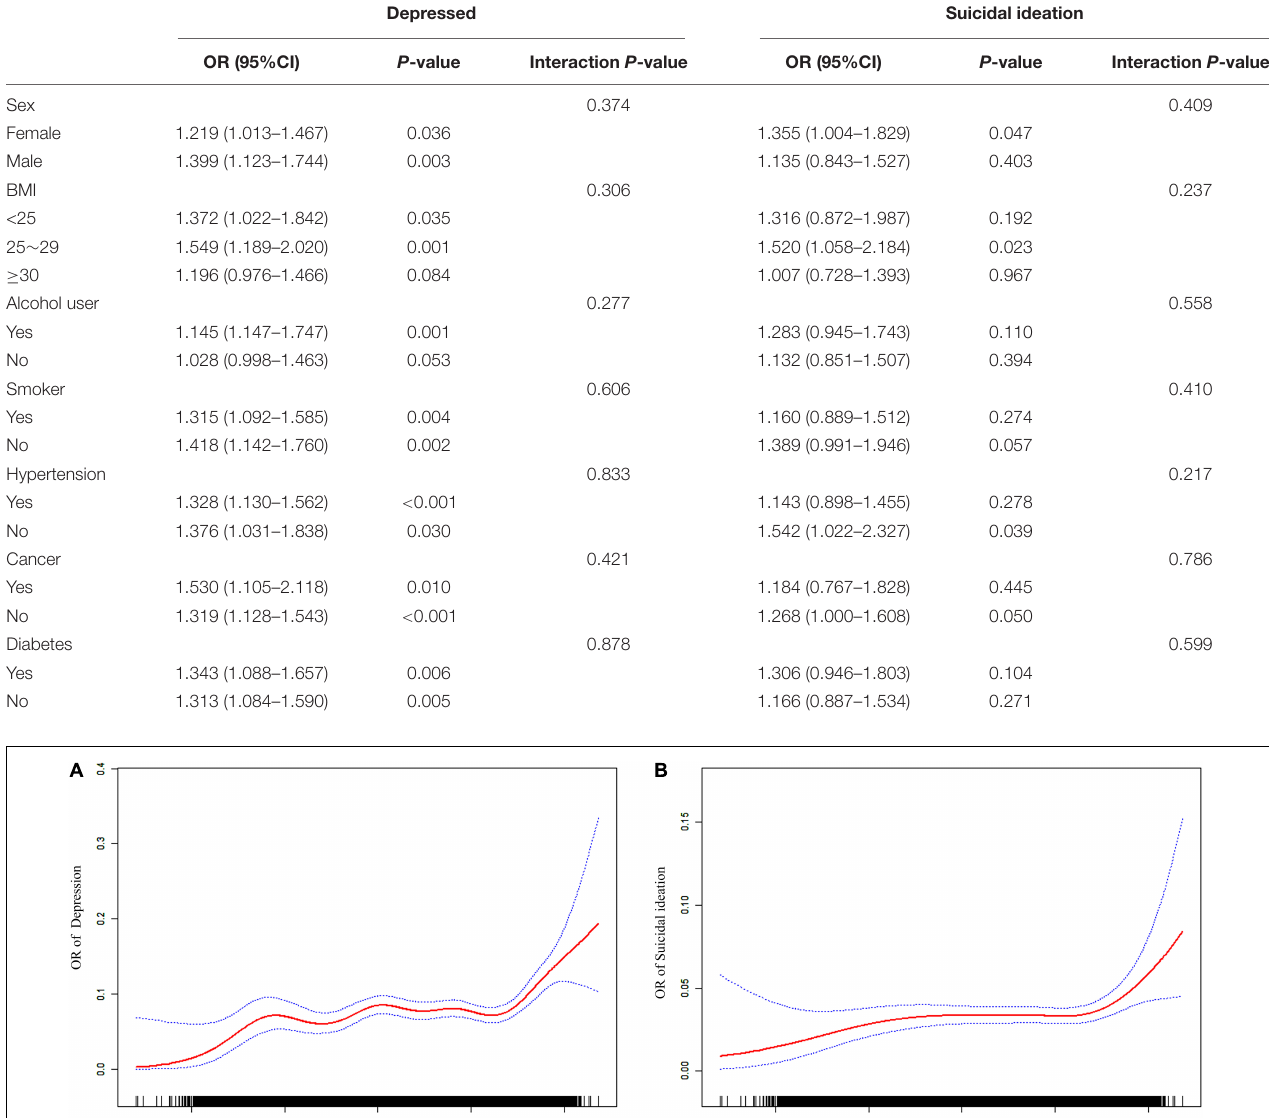
TABLE 3 | Subgroup multi-factor logistic regression analysis for the association between DII high-level and outcomes.